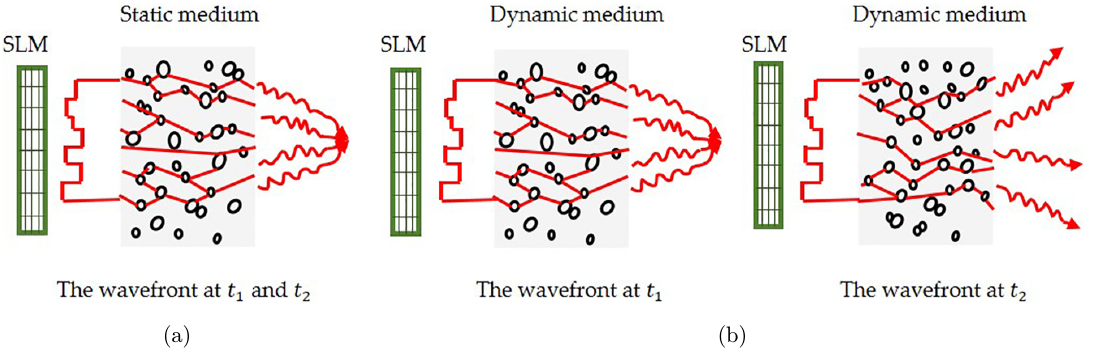
Fig. 1. Wavefront through static and dynamic media at di®erent times. (a) Wavefront at t 1 and t 2 through a static scattering medium and (b) Wavefront at t 1 and t 2 through a dynamic scattering